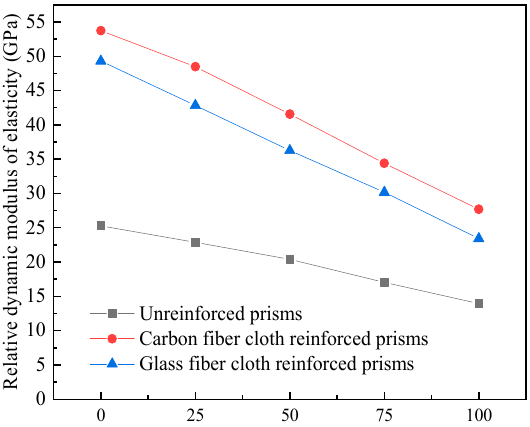
Figure 7. Variation in relative dynamic elastic modulus.